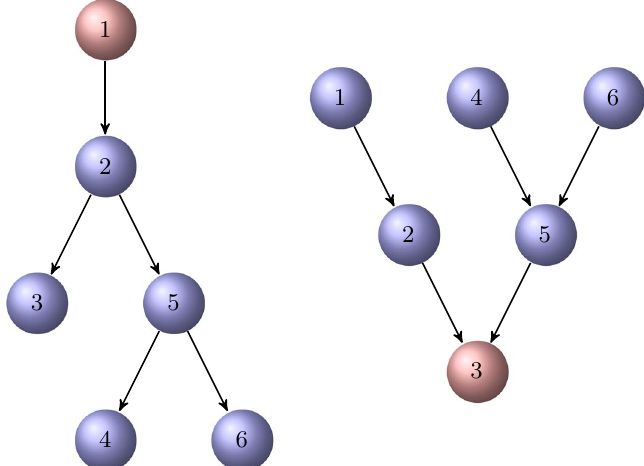
Fig. 5 The directed chained structure of the spanning trees T 1 out and T 3 in in Fig.